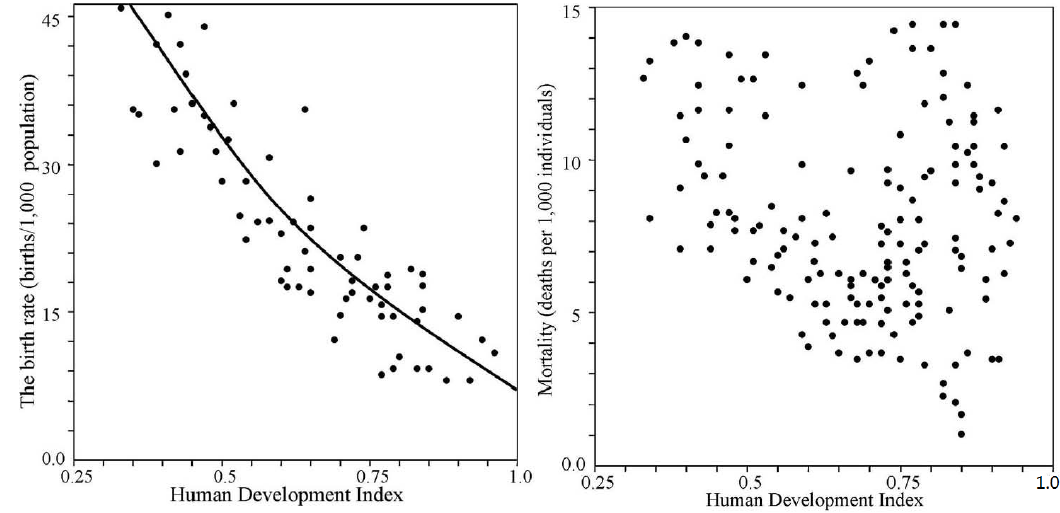
Figure 4. Comparison of food production indicators in developed countries and weakly developed countries.